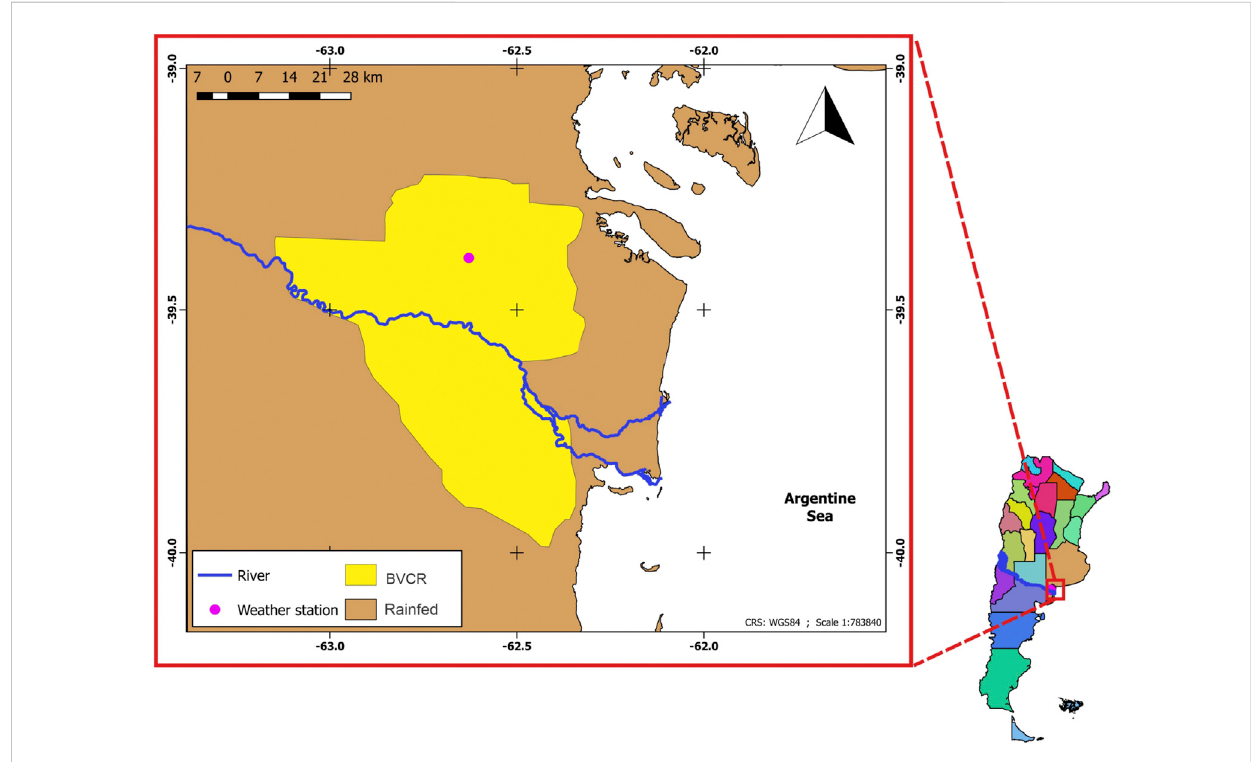
FIGURE 7 Weather station.